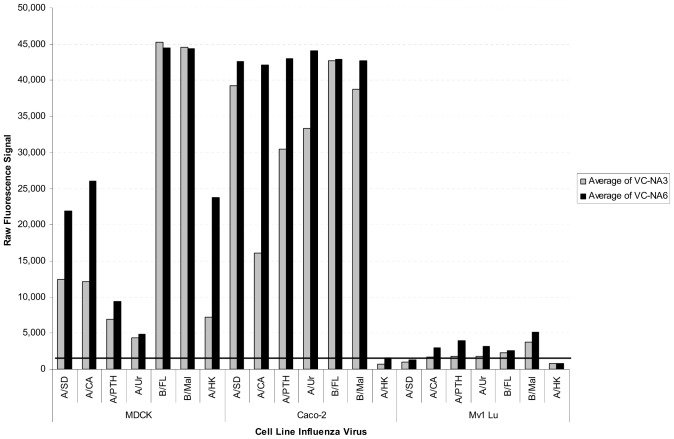
NA activity in virus infected control spent supernatants at day 3 and 6 post-infection.Approximately 100 FFU of each virus type/subtype (see Materials and Methods for virus nomenclature) were used in neutralization assays. Spent culture medium supernatants from un-neutralized virus control wells were harvested on Day 3 (gray) and Day 6 (black) and tested for NA activity. The raw fluorescence signals are plotted for each type/subtype by cell line (MDCK, Caco-2, and Mv1 Lu). The NA activity presented is the average of 3 test days. The solid black line indicates the cell control threshold for determining whether virus replication was reportable above background.